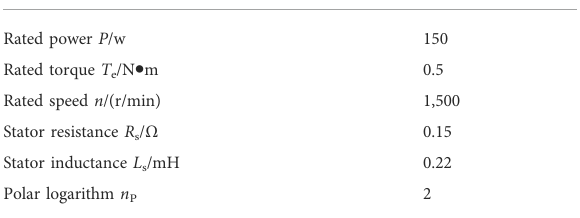
TABLE 1 The parameters of